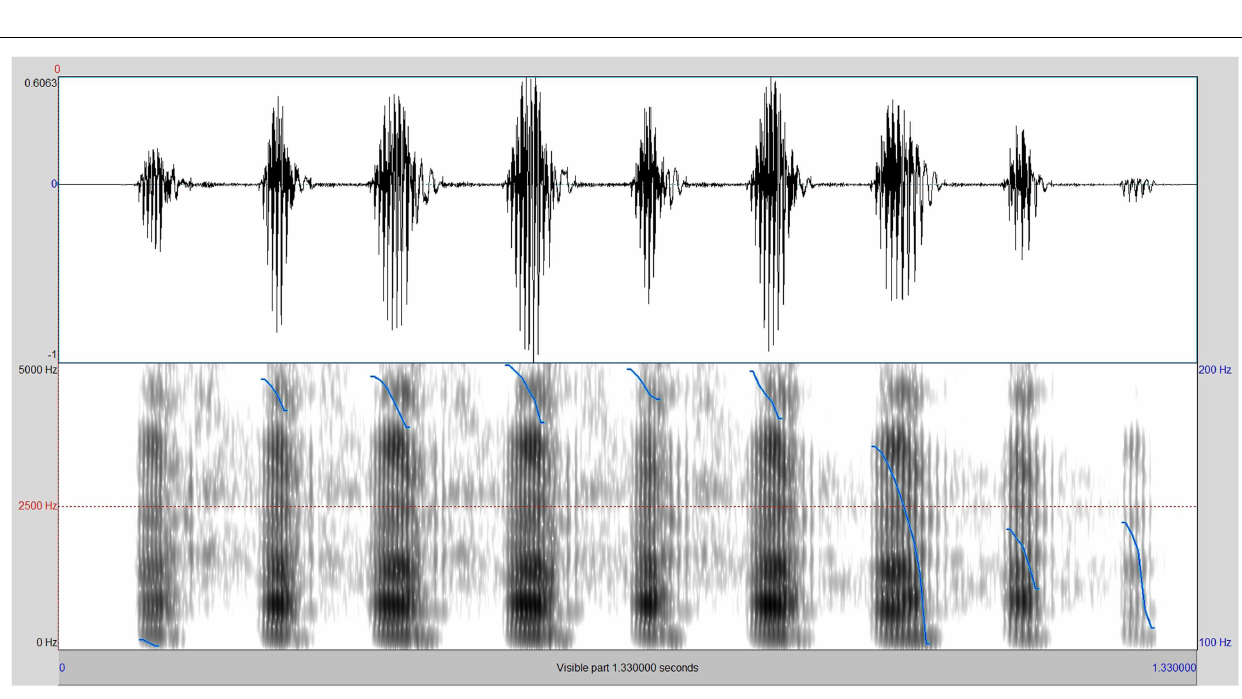
FIGURE 3 | Spectrogram of the vocal laughter stimulus being perceived as most malicious by the gelotophobes